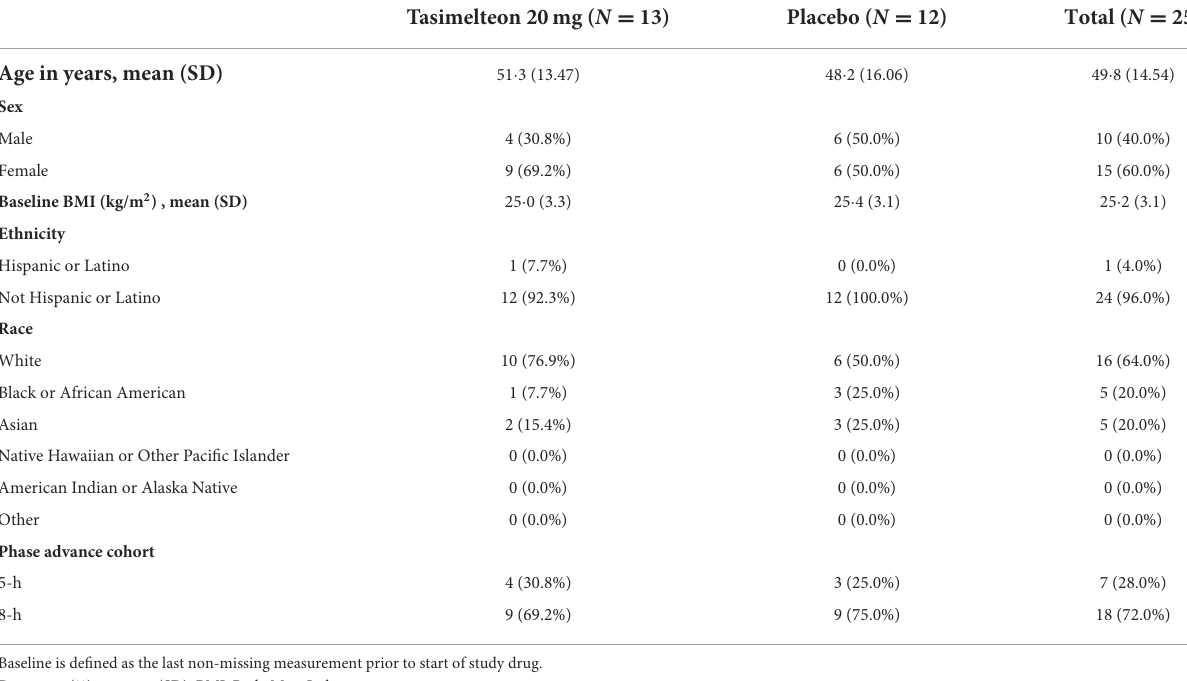
TABLE 1 Baseline characteristics for the ITT population.